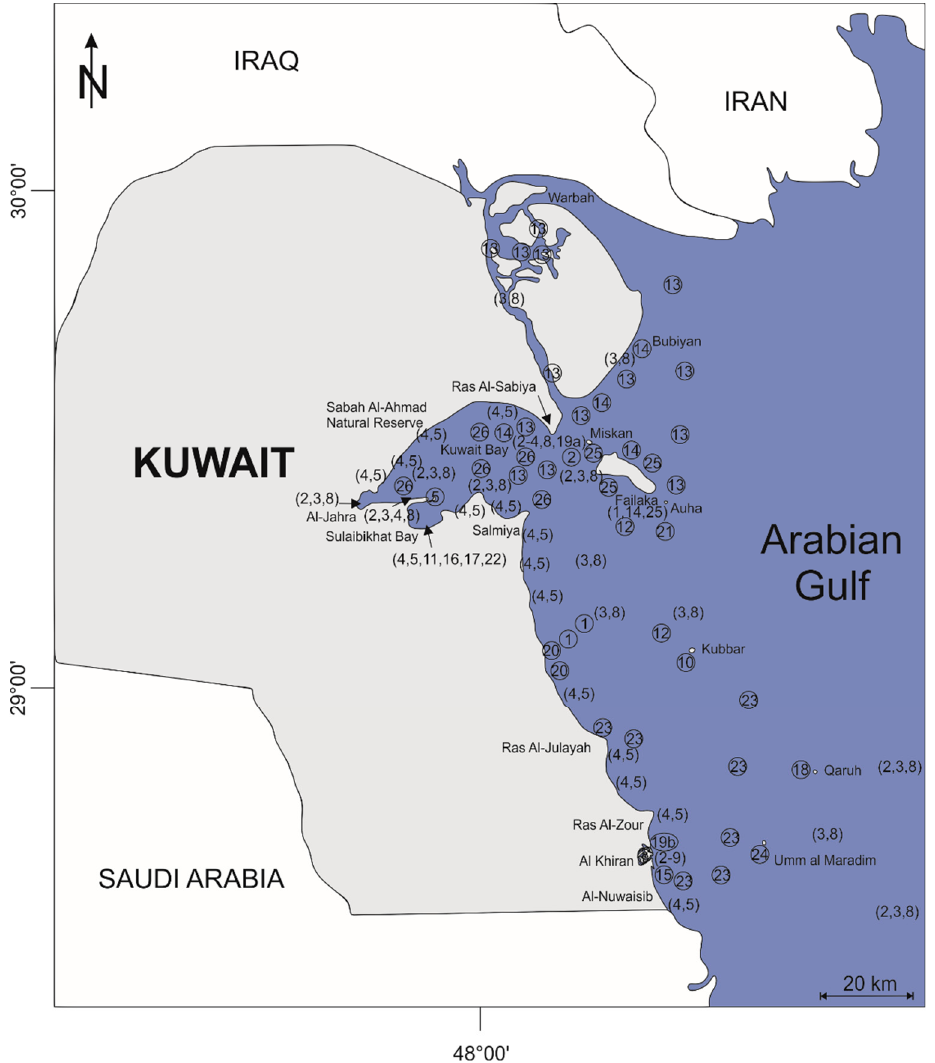
Figure 1. Location map of the Kuwait territorial waters, showing the geographical location of the investigated areas (numbers are organized by date of publication). (1) Mina Al-Ahmadi and south of Failaka Island [39]; (2) o ff shore area of Kuwait [40]; (3) Kuwait shoreline and the o ff shore area between Kuwait and Saudi Arabia [41]; (4) tidal flats from Al-Sabiya to Al-Nuwaisib, including the Sulaibikhat Bay and reefal flats of Umm Al-Namil Island and Al-Akaz [42]; (5) tidal flats from Al-Sabiya to Al-Nuwaisib, including the Sulaibikhat Bay and reefal flats of Umm Al-Namil Island and Al-Akaz [43]; (6) Khor Al-Nhaim lagoon in the Al-Khiran area [44]; (7) Al-Khiran area [45]; (8) Kuwait shoreline and the o ff shore area between Kuwait and Saudi Arabia [46]; (9) tidal and intertidal channels within two connected creeks (Khor Al-Mufateh and Khor Al-Mamlaha) in the Al-Khiran area [47]; (10) Kubbar Island [48]; (11) the Sulaibikhat Bay [49]; (12) o ff shore area of central Kuwait [23]; (13) the Shatt al-Arab Delta [50]; (14) the Western Bubiyan area and the surrounding of three islands (Failaka, Auha and Miskan) [51]; (15) Khor Iskandar, close to Al-Khiran area [52]; (16) Shuwaikh area [53]; (17) the Sulaibikhat Bay [29]; (18) Qaruh Island [54]; (19a) Ras Al-Subiya and (19b) Ras Al-Zour [55]; (20) Mina Ahmadi and Mina Abdullah [56]; (21) south of Failaka Island [57]; (22) the Sulaibikhat Bay [30]; (23) carbonate ramp transect in the southern part of Kuwait [58]; (24) Umm al Maradim Island [28]; (25) Auha, Failaka and Miskan Islands [59]; (26) Kuwait Bay: present study. To the best of our knowledge, the first investigation of benthic foraminifera in Kuwait was carried out by [39], who identified 73 species in o ff shore areas around Mina Al-Ahmadi and